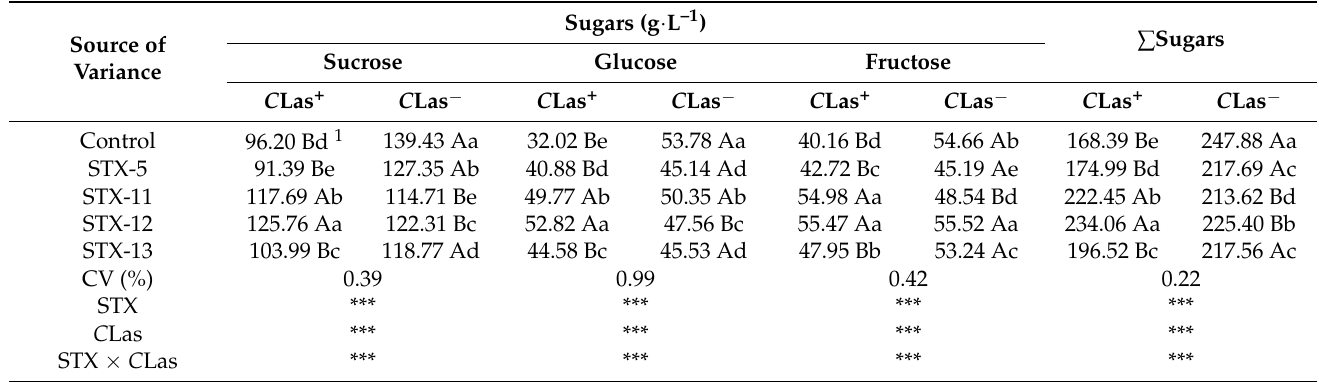
Figure 6. Juice (%) and soluble solids contents (SSC, °Brix), titratable acidity (TA, g·100 mL –1 ), and SSC/TA ratio for fruit from Candidatus Liberibacter asiaticus ( C Las + )-inoculated and non-inoculated ( C Las − ) STX IA transgenic/non-transgenic control plants of Pera sweet orange ( Citrus × sinensis ). Box plots followed by the same capital and lowercase letter do not significantly differ in regard to STX transgenic lines and C Las inoculation, respectively, according to the Tukey’s test. Significance level: p ≤ 0.001.